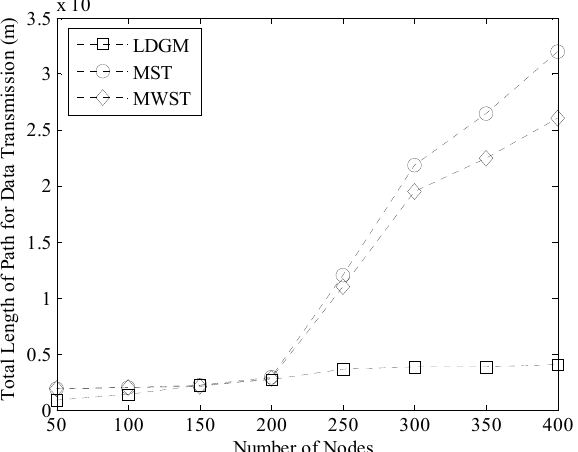
Figure 29. Total length of path for data transmission (100 m × 100 m, 200 nodes).